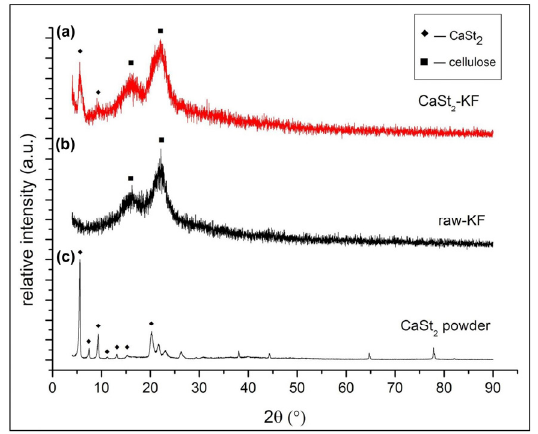
Figure 3. (Color online) XRD patterns of ( a ) CaSt 2 -KF, ( b ) raw-KF, ( c ) synthesized CaSt 2 powder.